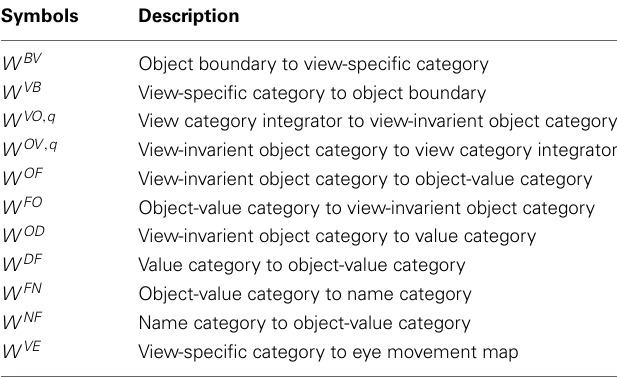
Table A2 | The adaptive weight variables in the model mathematical